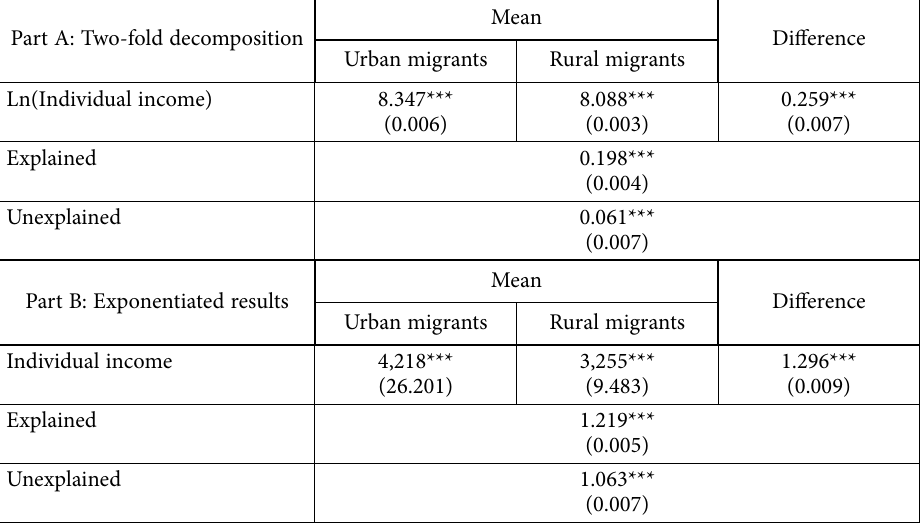
Table 2. Blinder-Oaxaca decomposition of income Part A: Two-fold